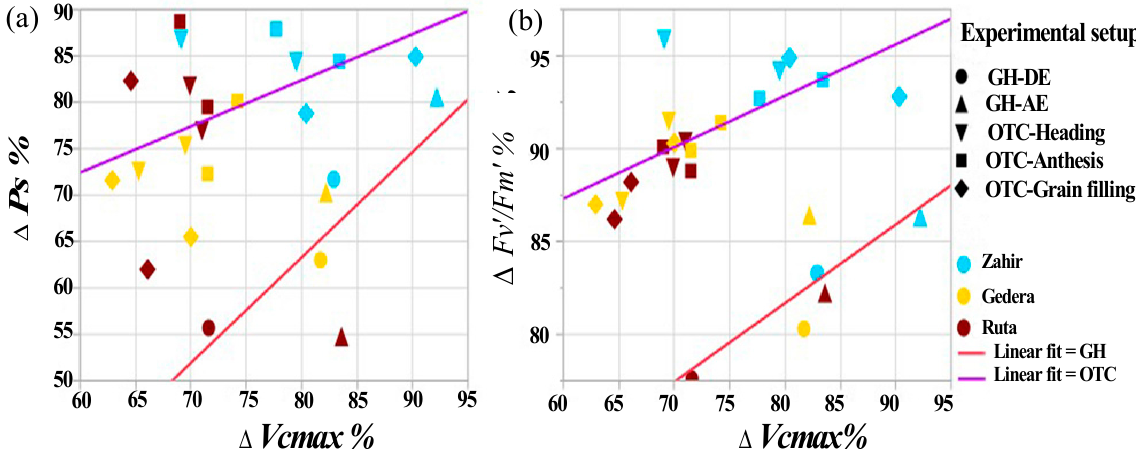
Figure 10. Relationship between physiological parameters across all experiment durations and cultivars. Presented are scatter plots for the differences (in percentages) in physiological parameters between enriched O 3 and controls for Ps ( Δ Ps ), Vcmax ( Δ Vcmax ) and Fv ′ /Fm ′ ( Δ Fv ′ /Fm ′ ). (a) Δ Ps vs. Δ Vcmax , and (b) Δ Fv ′ /Fm ′ vs. Δ Vcmax . Presented data are for all cultivars under O 3 stress in both OTCs (seasons I and II, including all phenological stages; heading, anthesis, and grain filling) and the GH experiment, with measurements taken during O 3 exposure (GH-DE) and afterward (GH-AE).